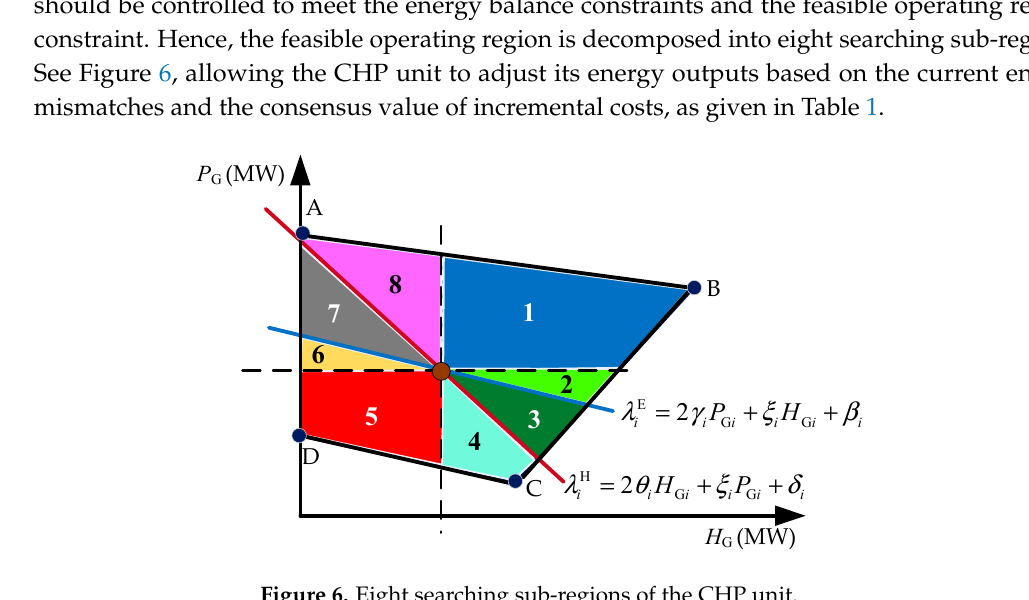
Figure 6. Eight searching sub-regions of the CHP unit. Table 1. Adjusting rules of energy outputs of CHP unit.